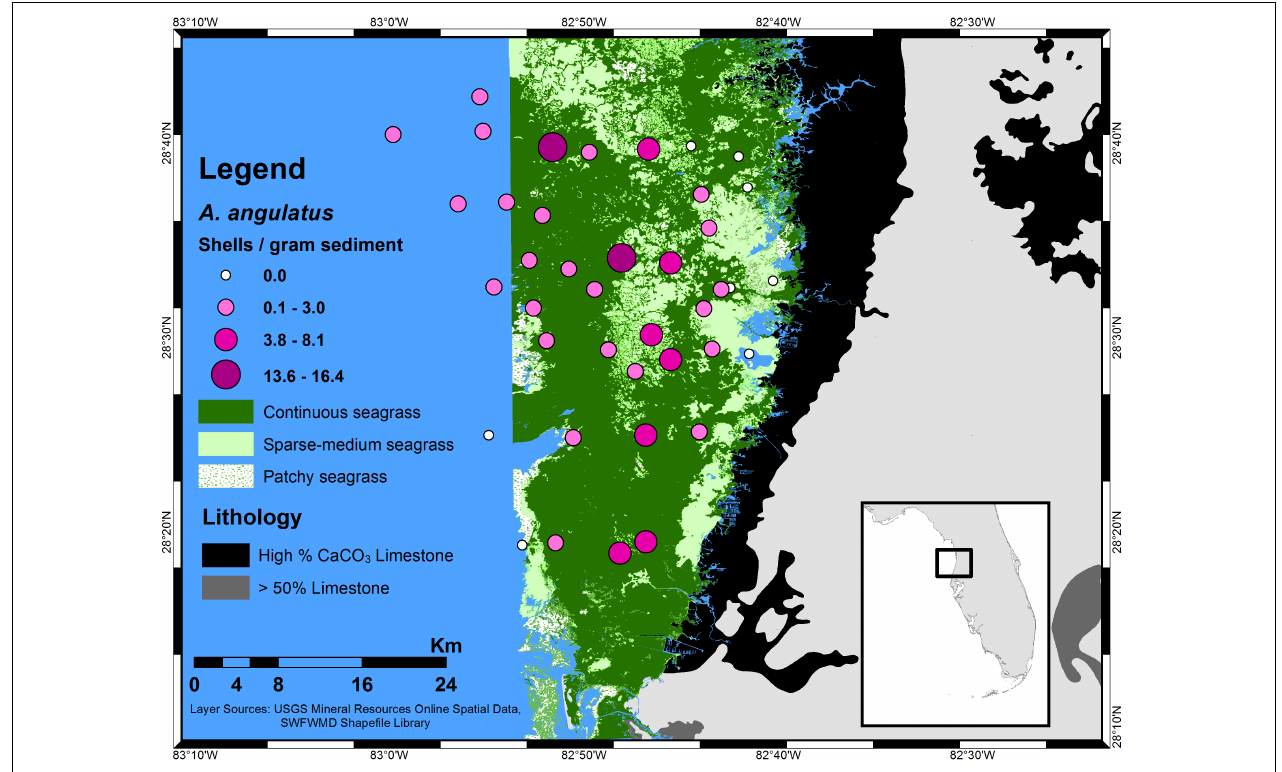
FIGURE 5 | Distribution of A. angulatus (by density) in the southern Springs Coast of central-west Florida. The larger, darker circles represent higher density; note the concentration of highest density along a band parallel with the coastline. The A. angulatus distribution is shown over seagrass of varying density. The foraminiferal abundances were determined from sediment analysis and presented in Beckwith (2016); a few additional samples were examined subsequent to Beckwith (2016) following identical